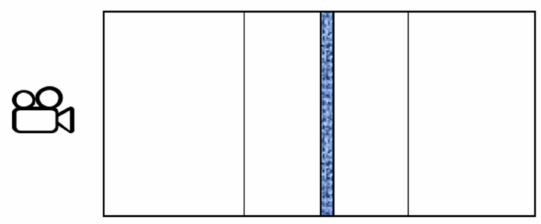
Figure 1. Video Cam SONY FDR-AX33 positioned behind the pitch.